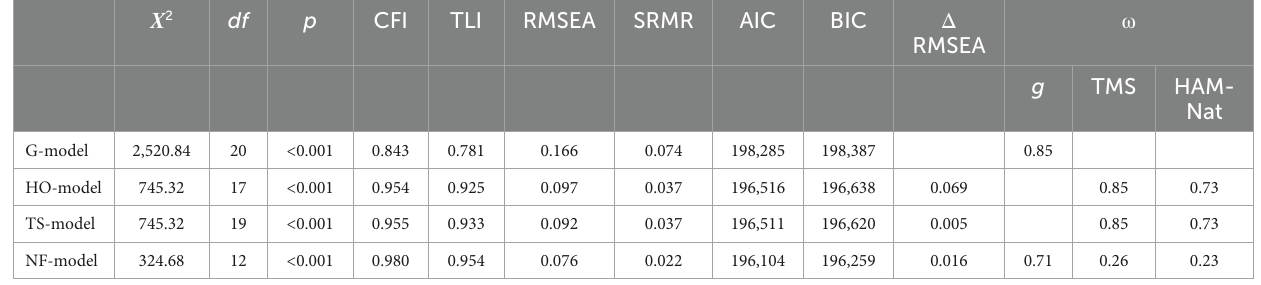
TABLE 4 Fit of the four tested